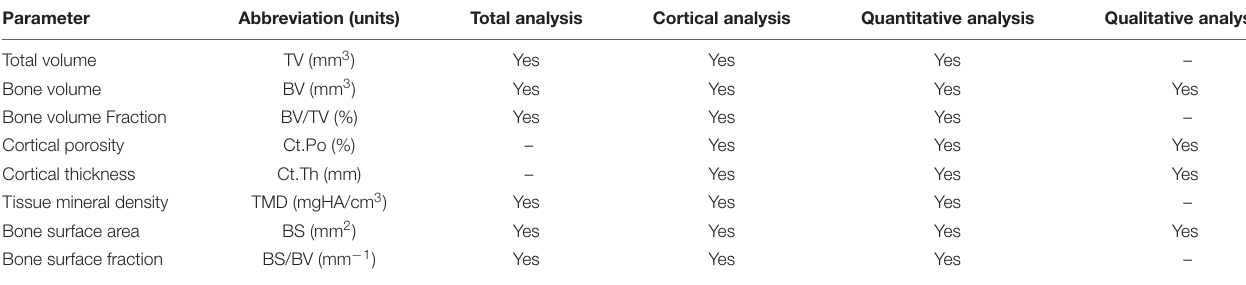
TABLE 1 | Bone microarchitecture and density parameters analyzed during total and cortical analysis. Parameter Abbreviation